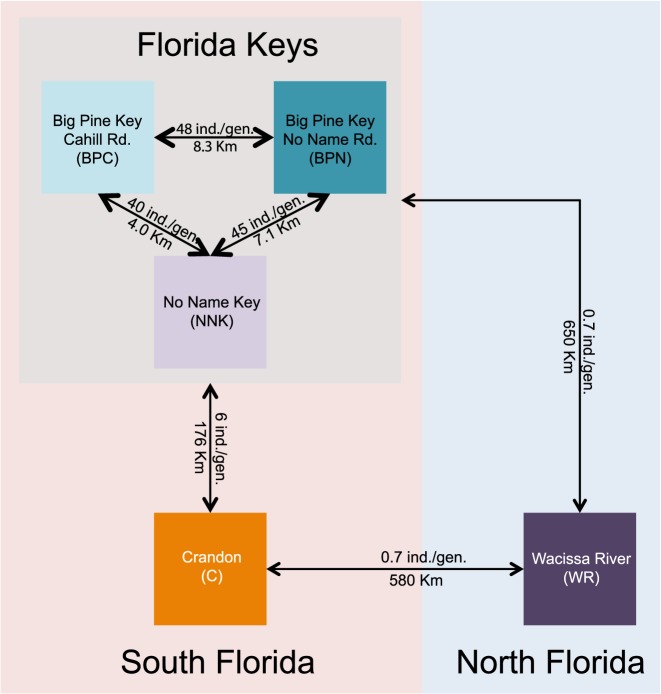
Migration Estimates.Diagram showing the estimated number of migrants per generation among all populations. Estimates were determined using a matrix of Slatkin’s linearized FST. Text with the lines between populations shows the estimated migration rate as well as the geographic distance between populations.